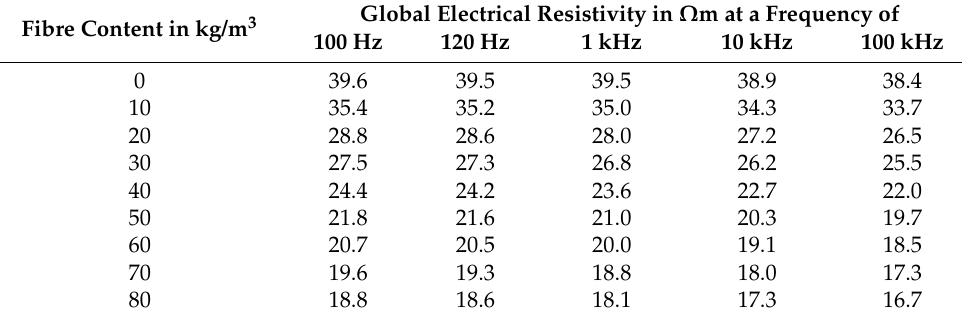
Table A16. Results of the resistivity measurements of the concrete mixture